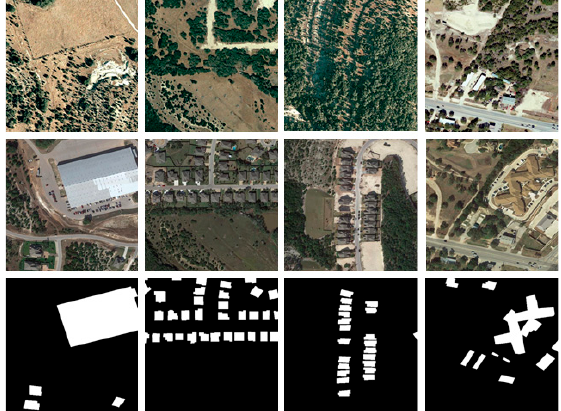
Figure 7. Image patch examples and corresponding reference images of the LEVIR-CD data set.